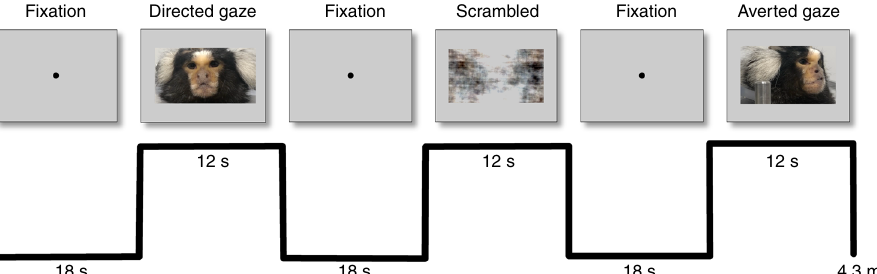
Fig. 5 Stimuli and experimental design for task-based fMRI. Top shows the stimuli for the fi xation condition and the task conditions, including directed gaze, averted gaze, and scrambled videos. The black line below the stimuli shows the